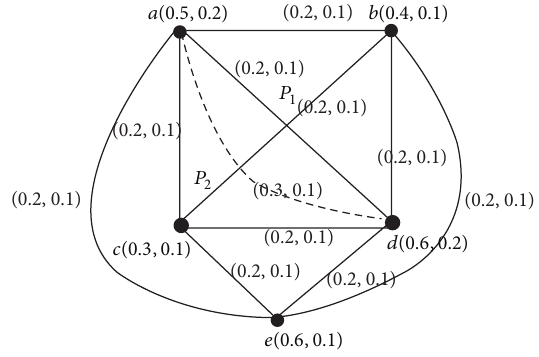
Figure 3: Intuitionistic fuzzy planar